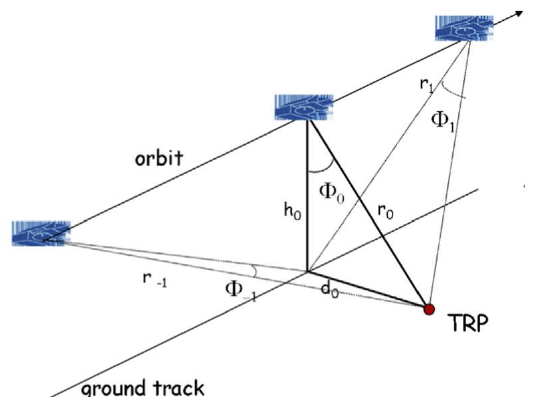
Figure 1. Geometry of the angle of arrival with transponder (TRP) measurements. CryoSat-2 sends and receives pulses to the transponder location along the overpass. Figure taken from [8].